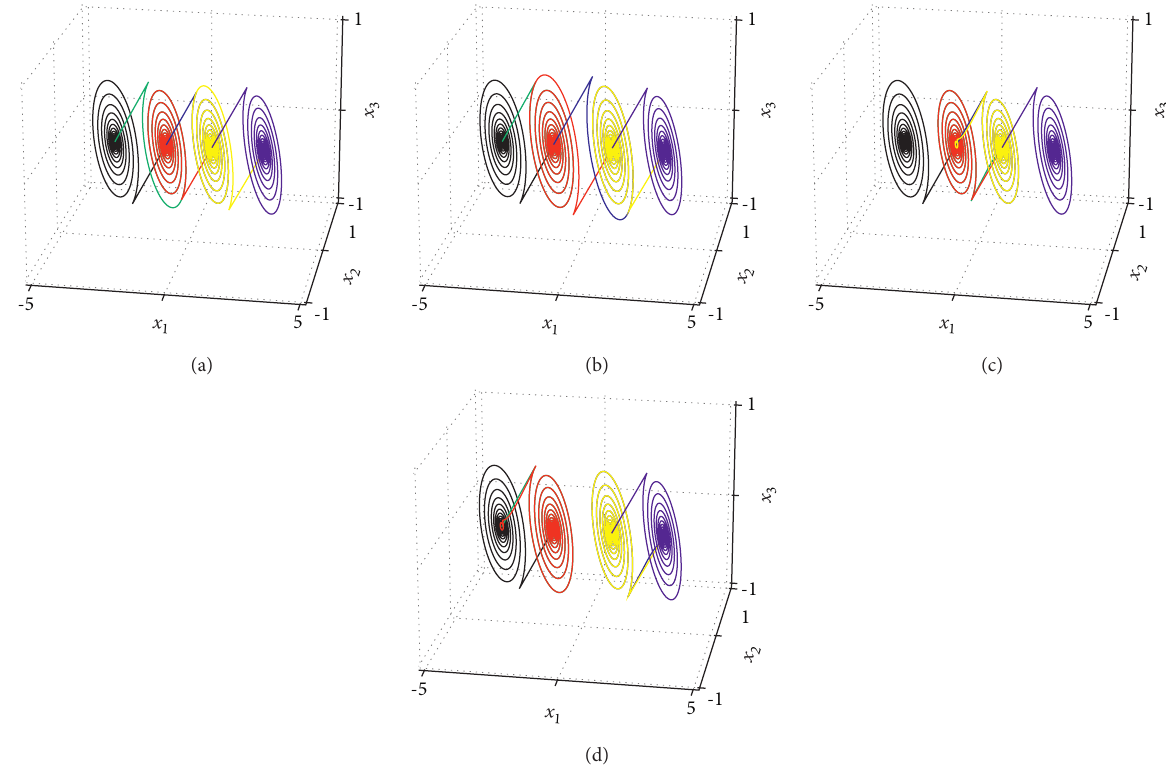
Figure 3: Heteroclinic orbits of the system given by (1), (3), (5), (13), and (15) for the parameters a � 0 . 2, b � 5, c � − 3, α � 1 and different values of c . There are six heteroclinic orbits for: (a) c − . 00001. Four heteroclinic orbits for (c) c